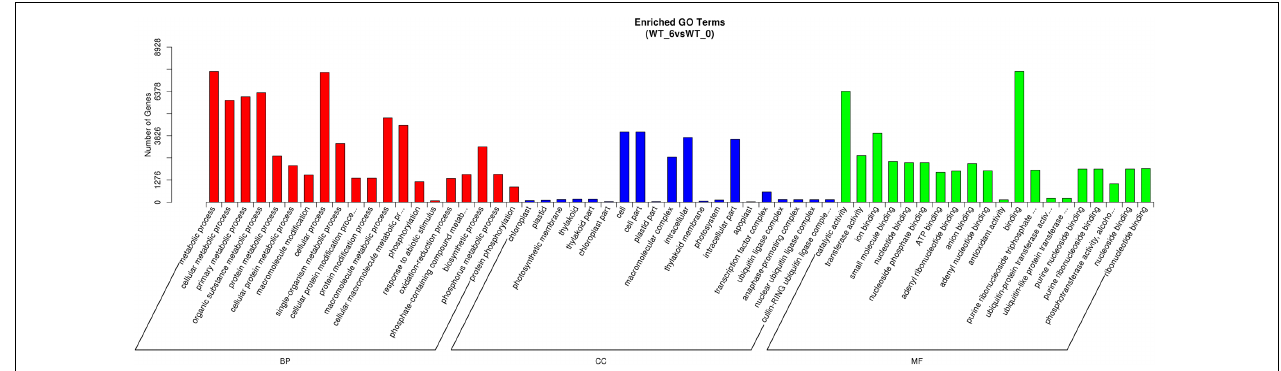
FIGURE 4 | Gene ontology classifications of DEGs between the control and heat stressed perennial ryegrass. The Y -axis represents the number of DEGs in a category. The results of heat stressed (WT_6) vs. control (WT_0) are summarized in three main categories: BP, CC, and MF.